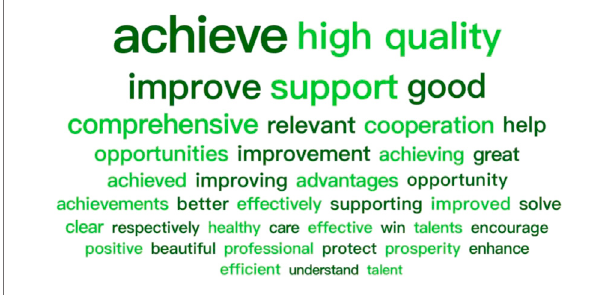
FIGURE 11 | Word cloud for positive words in carbon neutrality microposts (Note: dark and light green are used to see all positive words or phrases in a clearer way).